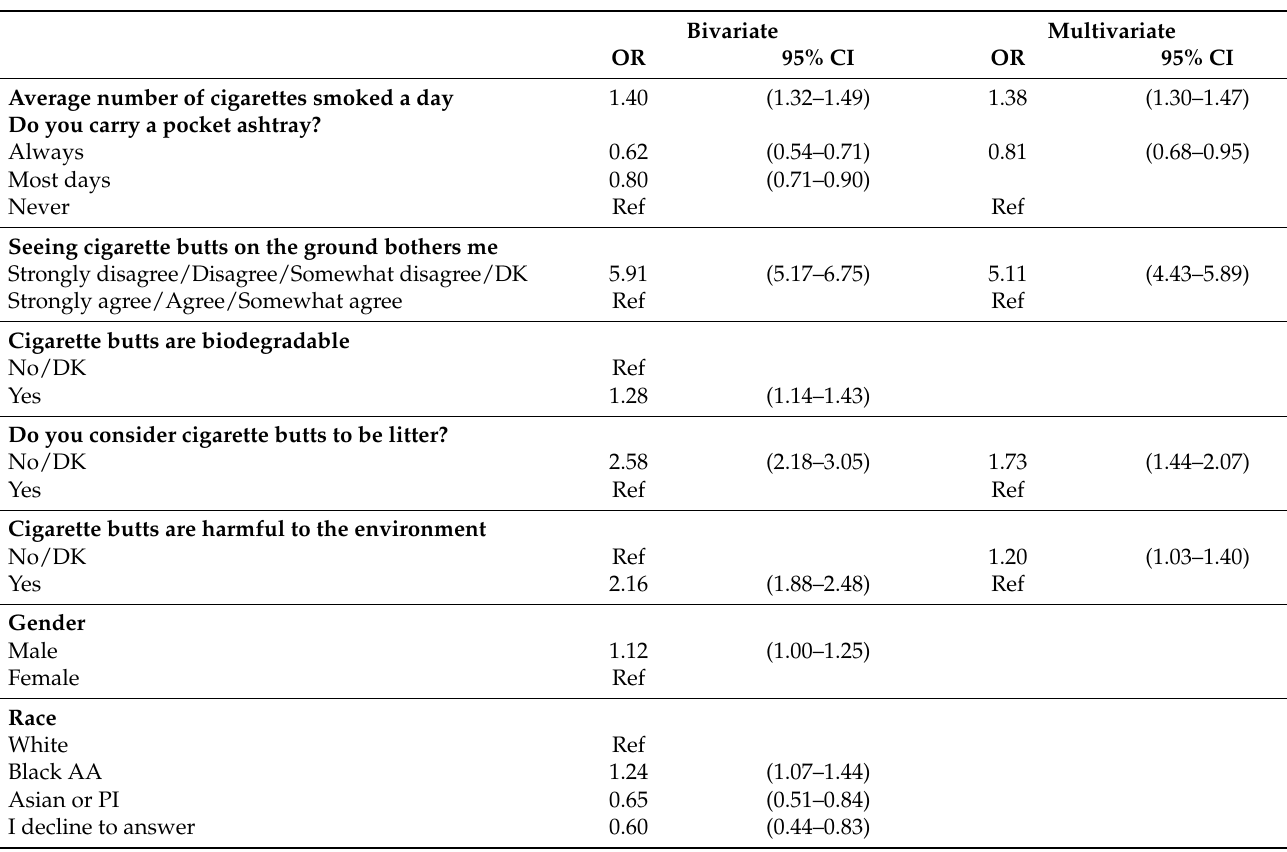
Table 3. Statistically significant predictors of ever littering † cigarette butts among college-age smokers ( n = 7532, p < 0.05).